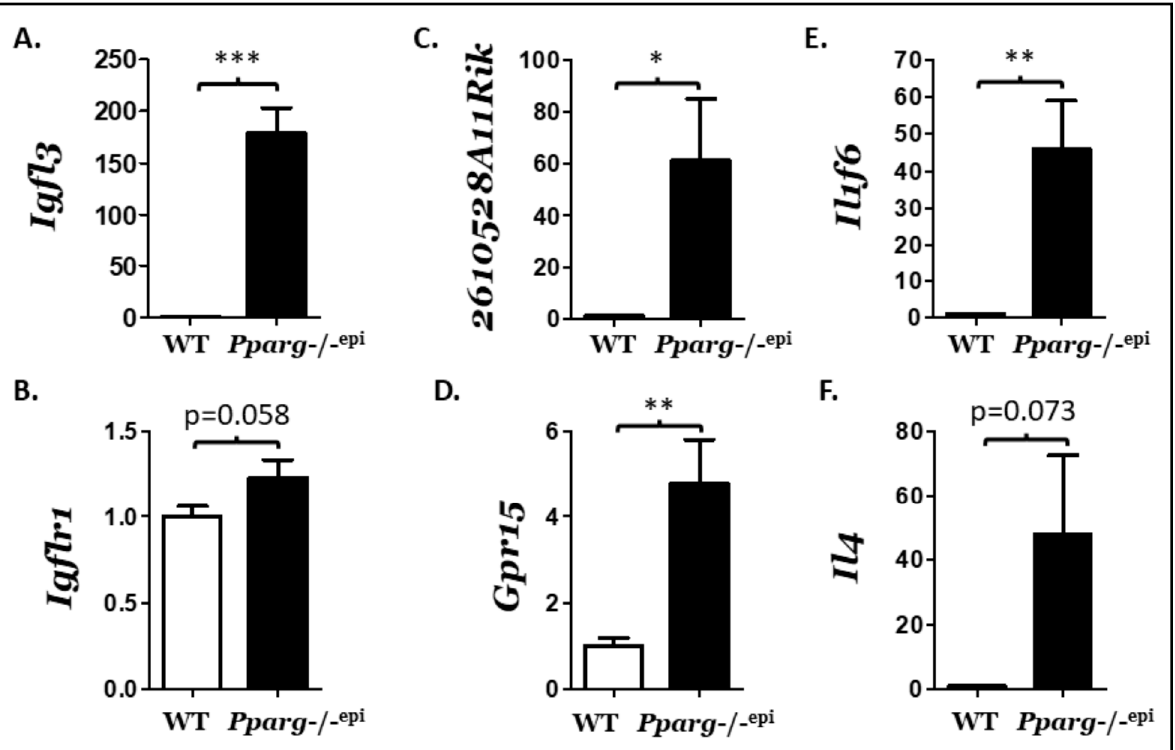
Figure 4. Confirmation of transcriptional upregulation for mediators associated with inflammatory skin disease. Total RNA was extracted from full-thickness non-lesional skin of C57. Pparg -/- epi ( Pparg -/- epi ) mice and wildtype (WT) sibling controls. Quantitative RT-PCR was then performed, and results were normalized to U. Results represent the fold-change in individual transcript levels between Pparg -/- epi and WT controls. ( A ) Relative expression of Igfl3 . ( B ) Relative expression of the IGFL3 receptor, Igflr1 . ( C ) Relative expression of 26 10528A11Rik . ( D ) Relative expression of the 2610528A11Rik receptor, Gpr15 . ( E ) Relative expression of Il4 . ( F ) Relative expression of Il1f6 (IL36 α ). *, p < 0.05; **, p < 0.01; ***, p < 0.001, 2- tailed t -test with Welch’s correction.